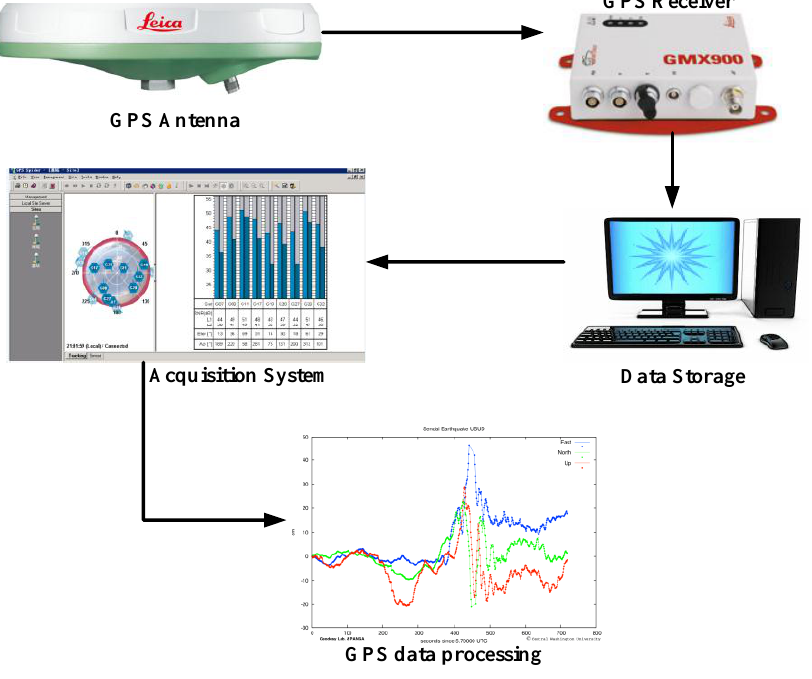
Figure 6. Global Positioning System (GPS) network diagram.